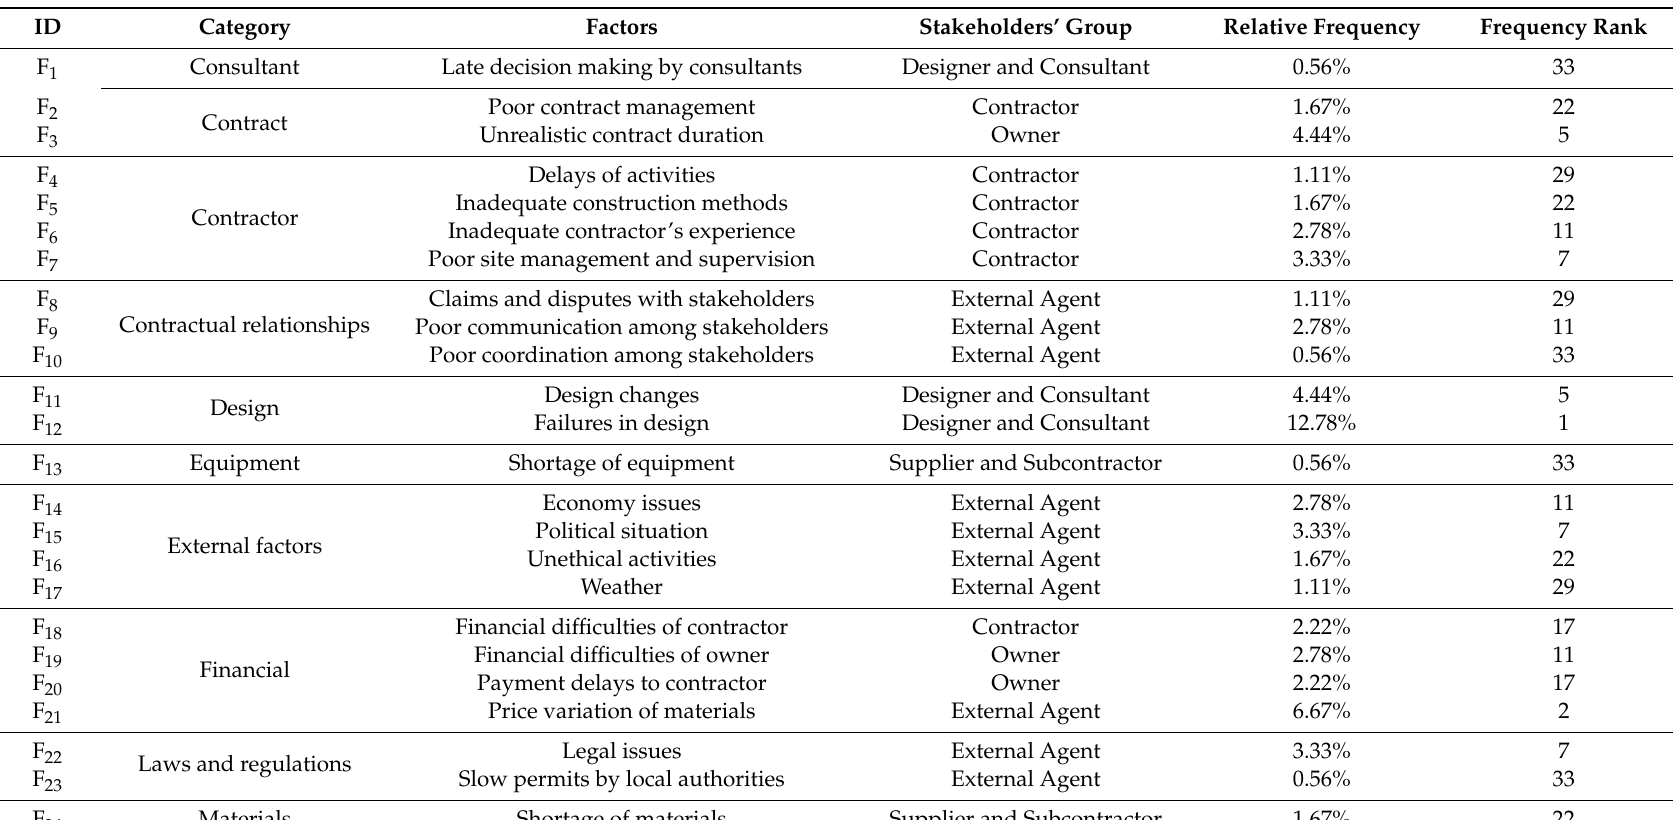
Table 4. Relative frequency by cost overrun